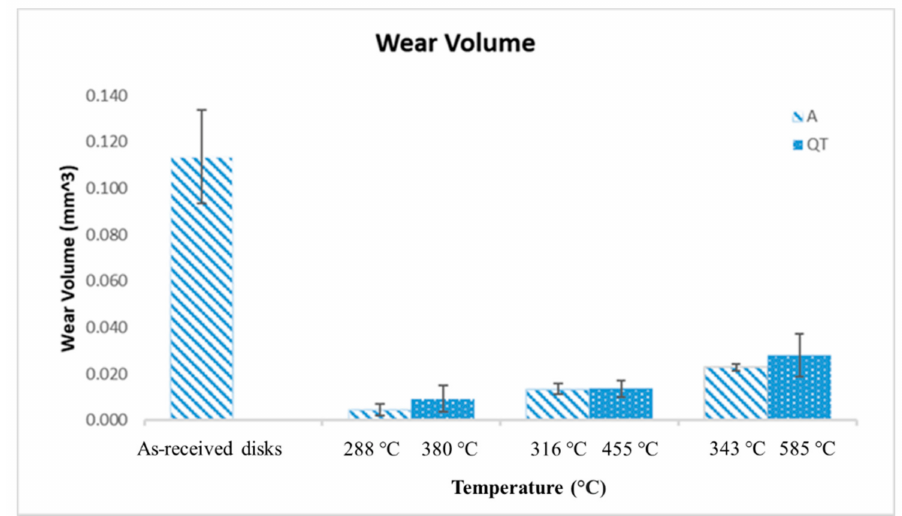
Figure 6. Wear volume of austempered disks and quenched-tempered